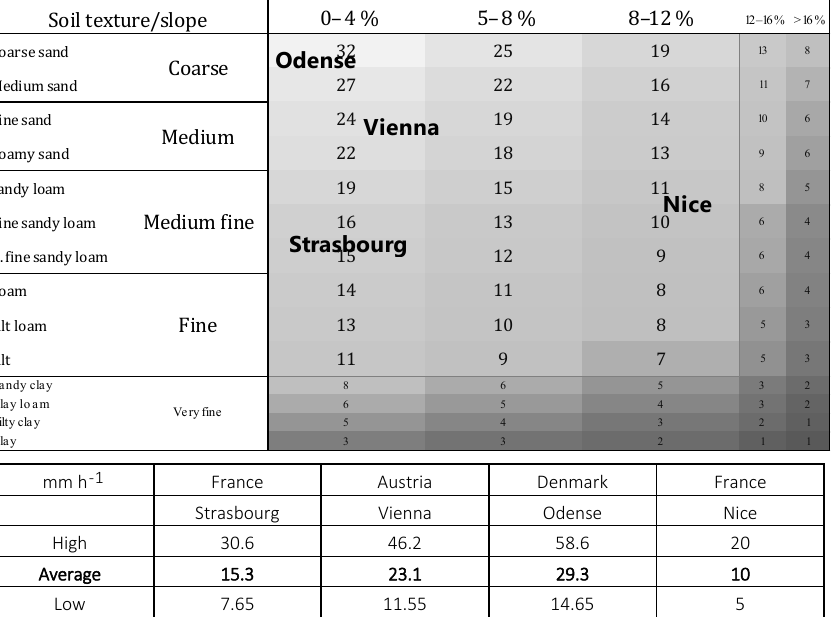
Figure 3. Potential infiltration rates (mmh − 1 ) for pervious areas in the four cities, calculated based on the primary soil texture and average slope within the cities. “Low” is calculated as half the average and “High” is twice the average, adapted from USDA (2016).